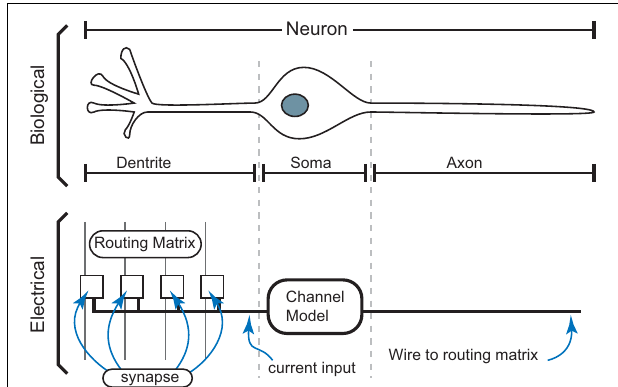
FIGURE 3 | Basic definition of neurons that uses biologically realistic transistor based models of neurobiological computation. A biological neuron is made up of its soma, dendrite, synapse, and axon components. For our electrical IC models, we will follow a similar block diagram for the basic components, including efficient models of synapses, channel regions in the soma, and communication of spikes to other synapses.